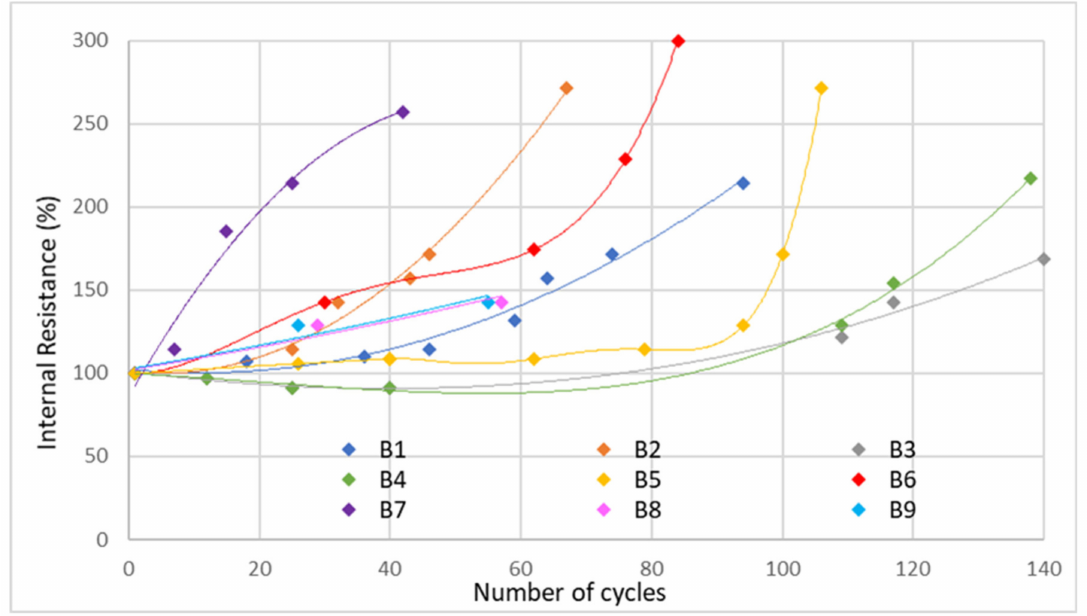
Figure 3. Internal resistance